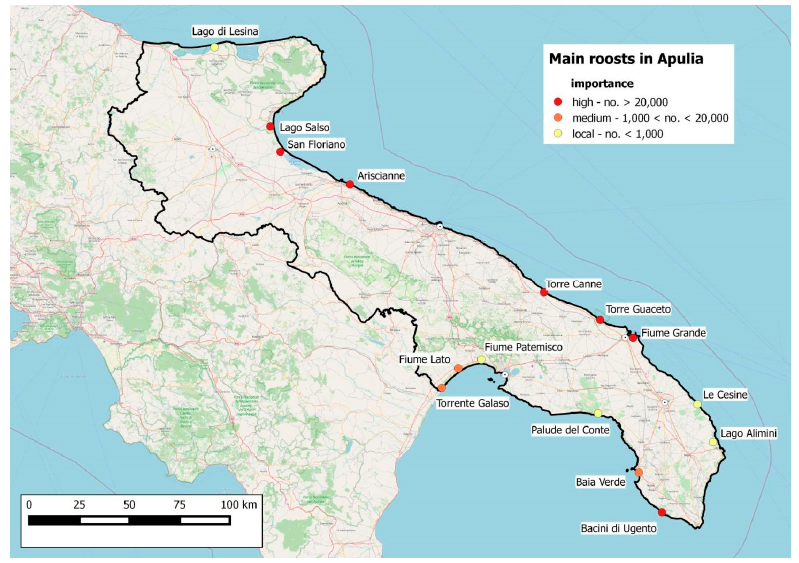
Figure 3. Identification of roosts and inspection areas within 70 km radius.